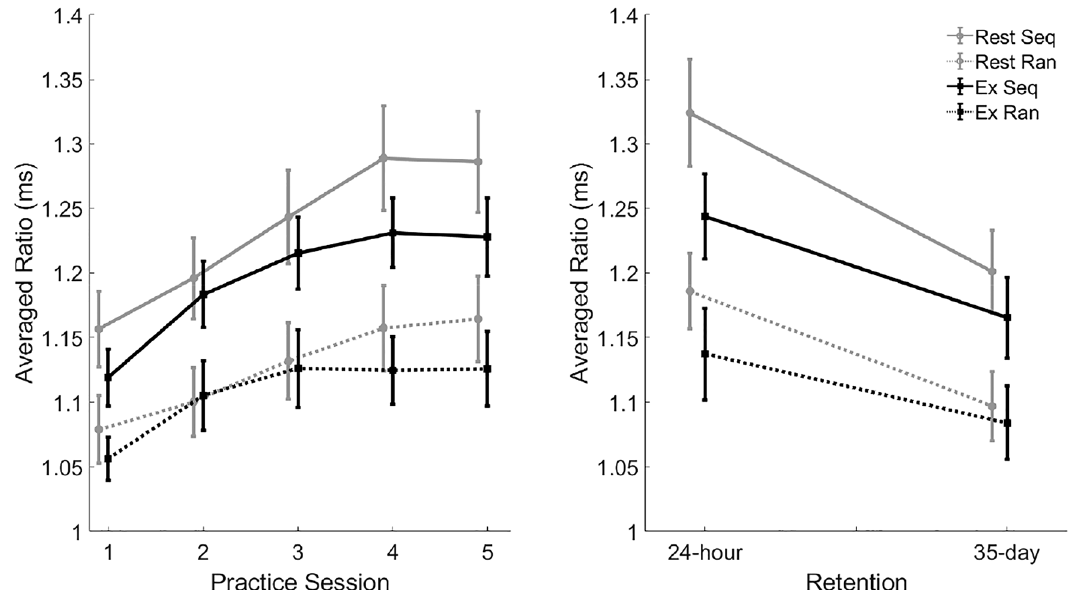
Figure 6. Averaged ratio reaction time (RT) as a function of practice session (left) and 24-h and 35-day retention session (right) for exercise and rest groups from the serial targeting task. All values were shown as a ratio relative to pre-test, then averaged across four blocks of practice each session. Higher values indicate better motor performance (left) or greater change associated with motor learning (right). Error bars represent